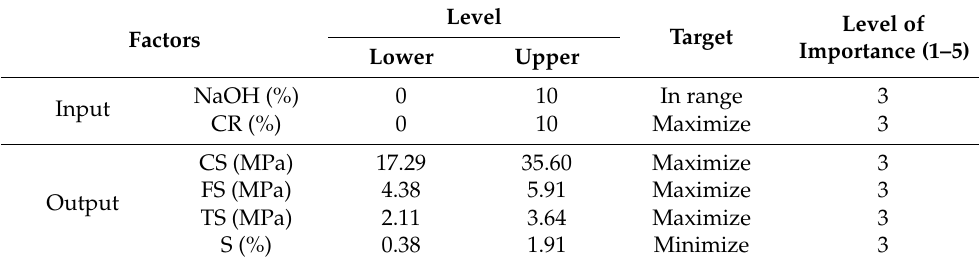
Table 5. Multi-objective optimization criteria and objectives.